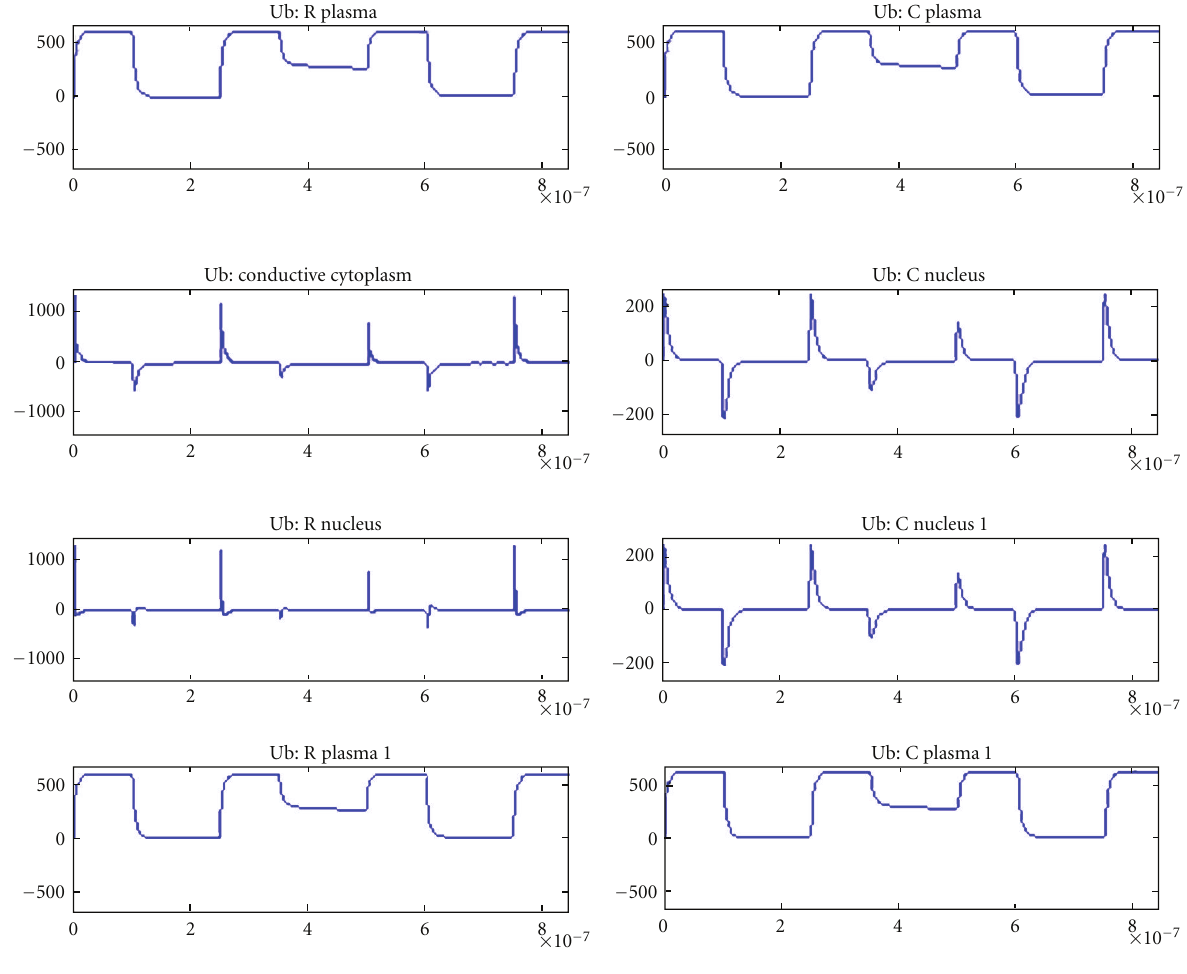
Figure 7: Voltage across various cell elements in tissue with two normal